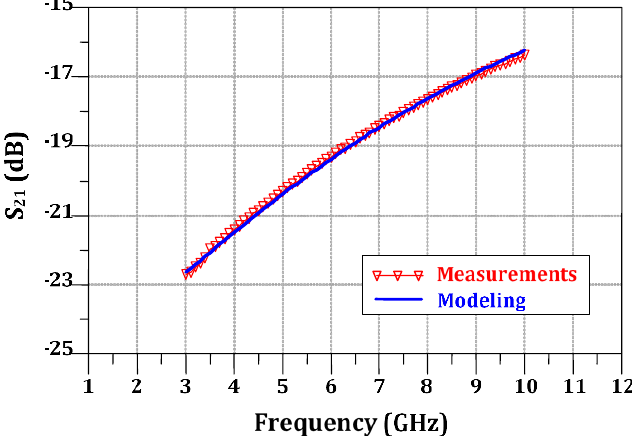
Figure 5. Measurements and modelling of transmission coefficient for the unbiased ( V d = 0 V) ZBD .